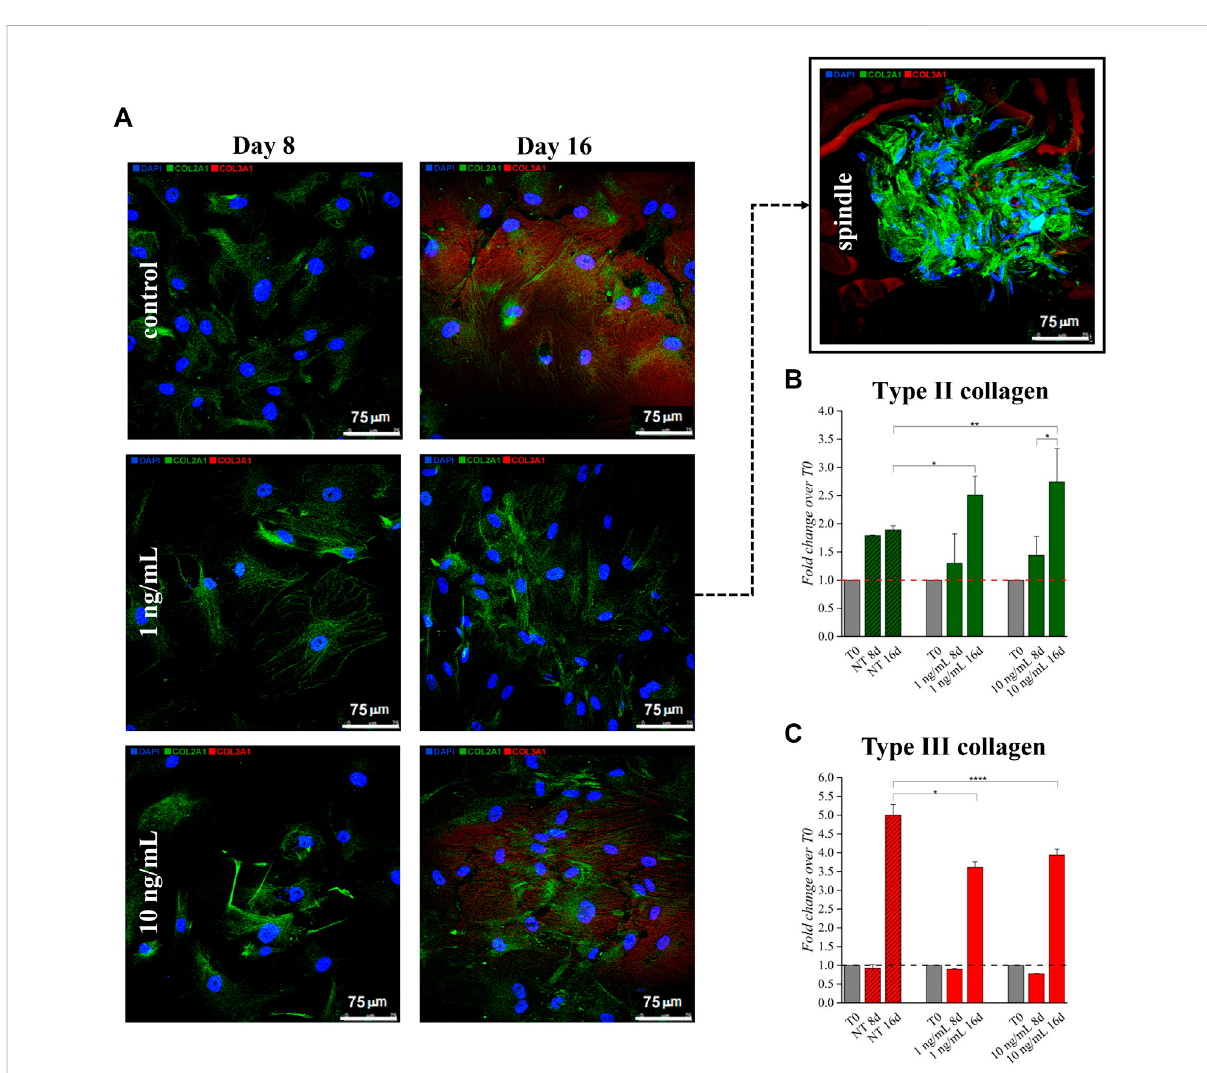
FIGURE 2 Effect of hTGF- β 1 on the expression of type II (stained in green) and type III (stained in red) collagens by BM-MSC monolayer. Spindle-shaped systemswereobservedatDay16onlywhen1 ng/ml hTGF- β 1wassupplemented (A) .HighertypeIcollagenstain wasobservedwhen10 ng/ml